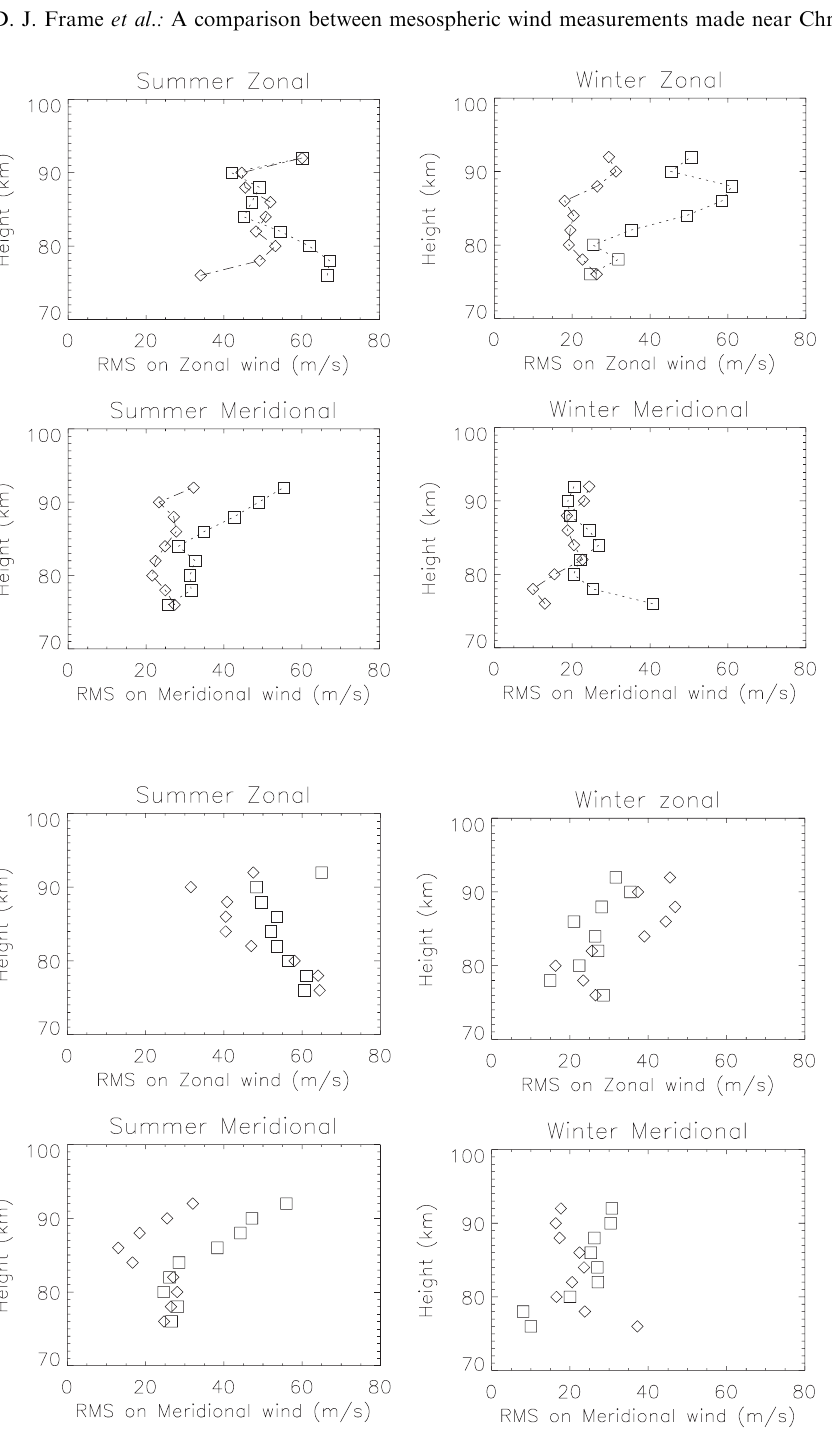
Fig. 9. RMS di(cid:128)erences between data which had more than the average number of contributory wind measurements for the six hour time-bin (diamonds) and data which had less than the average number of con- tributory wind measurements for the six hour time